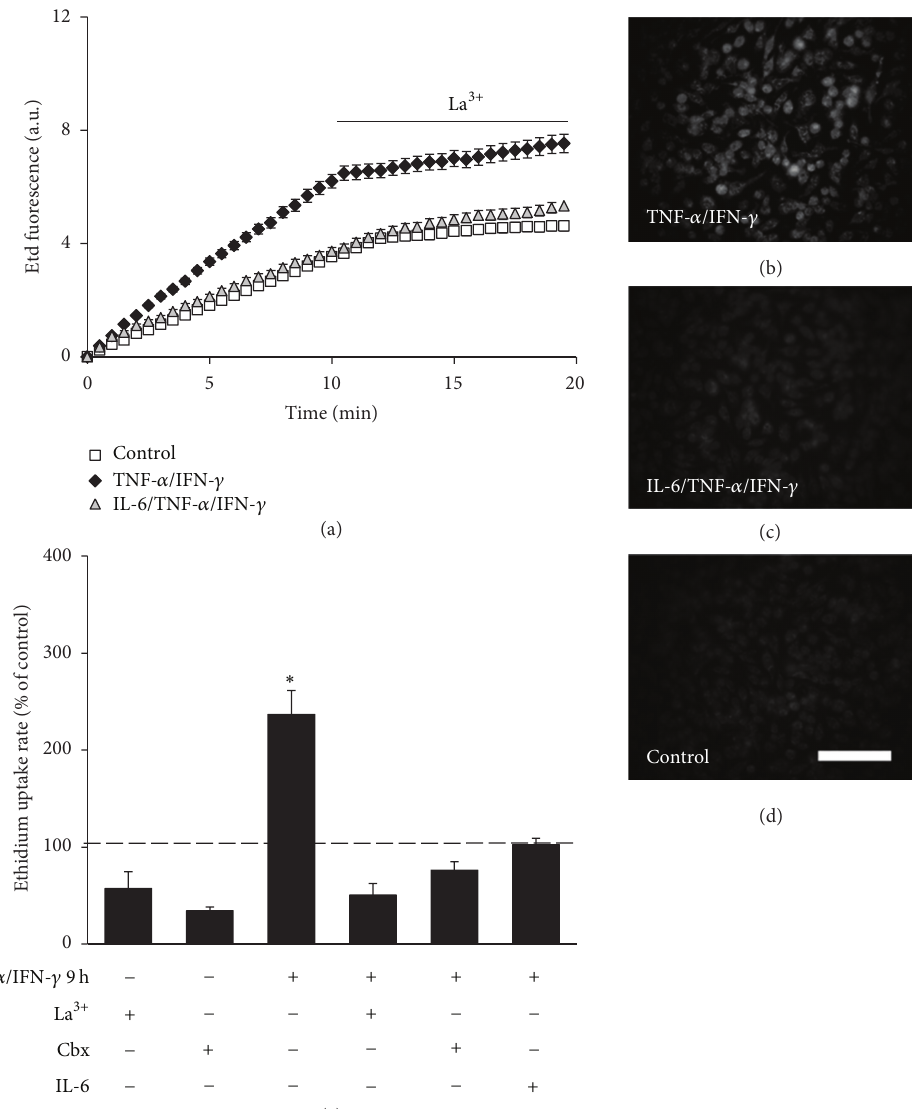
Figure 4: TNF- 𝛼 /IFN- 𝛾 induces membrane permeabilization in EOC20 cells. (a) Time-lapse measurements of ethidium (Etd) uptake in EOC20 cells under control conditions (white squares), or after treatment with TNF- 𝛼 /IFN- 𝛾 (black diamonds) or IL-6/TNF- 𝛼 /IFN- 𝛾 (gray triangles) for 9h. Each value represents the mean ± SEM of 30 cells. After 10min of basal uptake, 200 𝜇 M La 3+ was applied to the bath. (b)–(d) Representative fluorescence micrographs of Etd uptake after 10min of Etd uptake under indicated treatments, previous to La 3+ application. Scale bar: 100 𝜇 m. (e) Graph showing the acute effect of 200 𝜇 M La 3+ , 10 𝜇 M carbenoxolone (Cbx), or pretreatment with 50ng/mL of interleukin-6 (IL-6) Etd uptake rate expressed as percentage of control conditions (dashed line) in EOC20 cells treated with TNF- 𝛼 /IFN- 𝛾 for 9h. Each bar corresponds to the mean ± SEM, 𝑛 = 5 . ∗ 𝑃 < 0.05 versus control